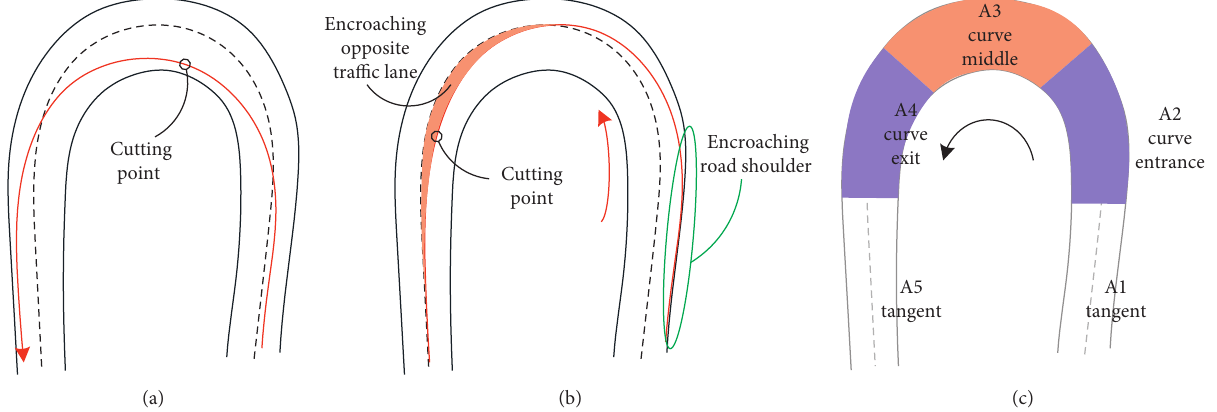
Figure 6: Curve cutting and opposite lane-occupying. (a) The driver cuts a curve near the middle of the curve; (b) vehicle strays from the lane and cuts the curve at curve exit; (c) segmentation of a hairpin curve.